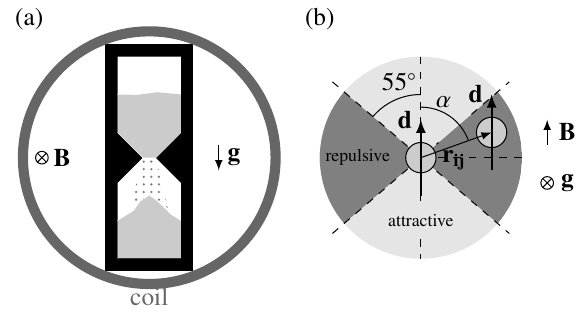
Figure 1. (a) Experimental setup made of a quasi 2D silo in a Hele-Shaw cell with a 45 ◦ funnel in its centre. The cell is filled with 500 µ m diameter steel beads. The cell is placed in a mag- netic coil generating a magnetic field perpendicular to the cell. (b) Top view of the left panel representing the dipolar interaction between two uniformly charged ferromagnetic beads character- ized by the dipolar moment d .